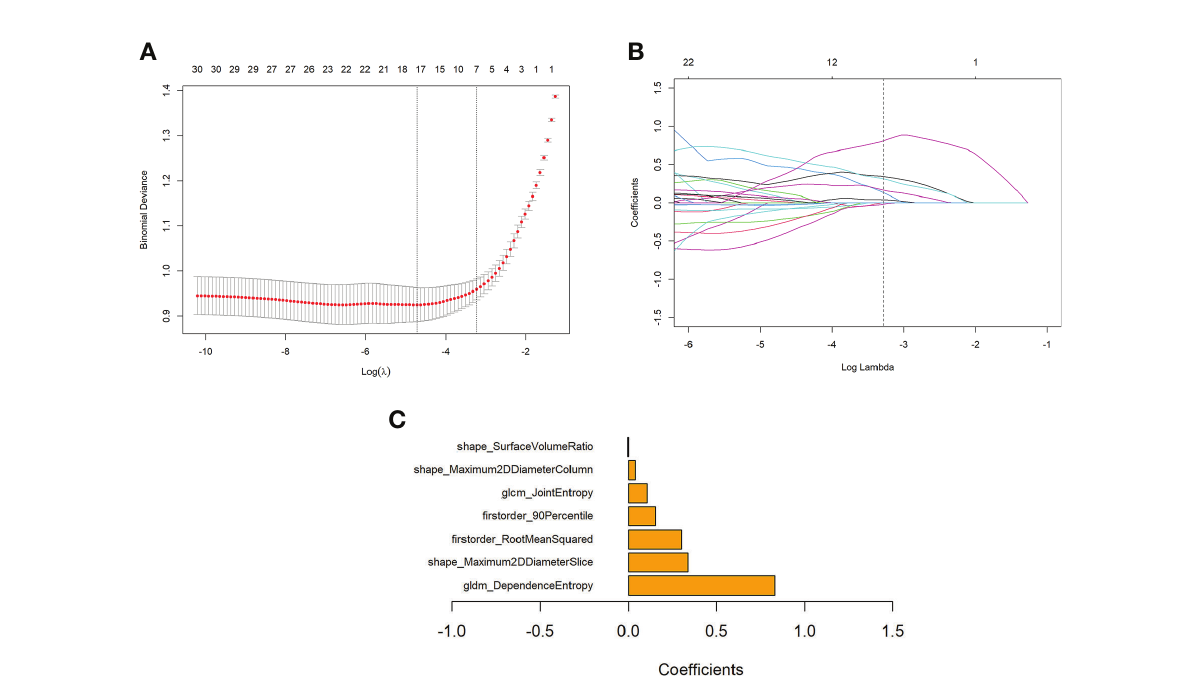
FIGURE 4 Features selection using the LASSO regression model and the selection of the tuning parameter l . (A) Change of binomial deviance with log( l ). The maximum log( l ) corresponding to the binomial deviance within 1 standard error from the minimum binomial deviance was chosen for the fi nal model. (B) Change of the number of features with non-zero coef fi cients with log( l ), as determined in a 10-fold validation. (C) Coef fi cients of the seven features retained in the